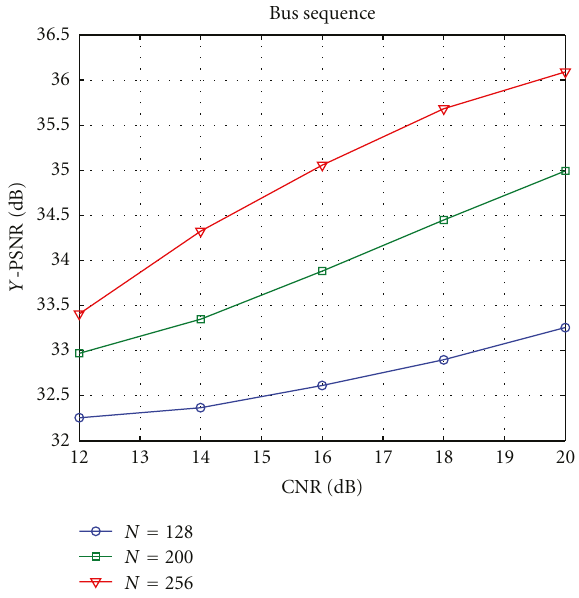
Figure 8: PSNR of BUS sequence using proposed near-optimal resource allocation scheme with varying number of subcarriers.